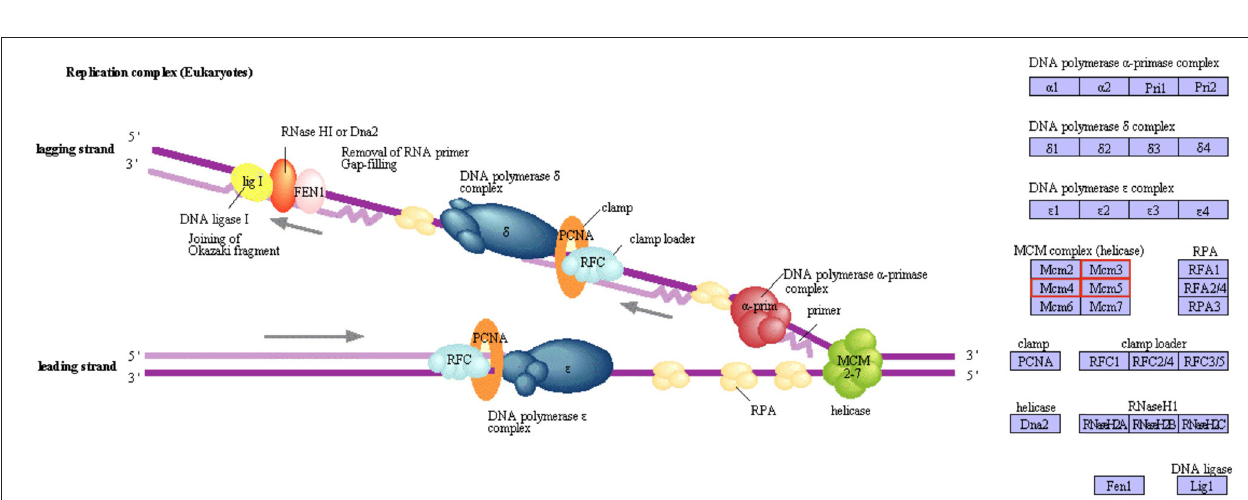
FIGURE 3 | A scattered plot of downregulated (A) and upregulated (B) enriched Kyoto Encyclopedia of Genes and Genomes (KEGG) pathways in the mix-based diet samples (M diet). The degree of KEGG enrichment is measured by the rich factor, the p -value, and the number of genes enriched in each pathway. The rich factor refers to the ratio of the DEGs number in the pathway and the number of all genes annotated in the pathway. Significant pathways are highlighted in yellow.